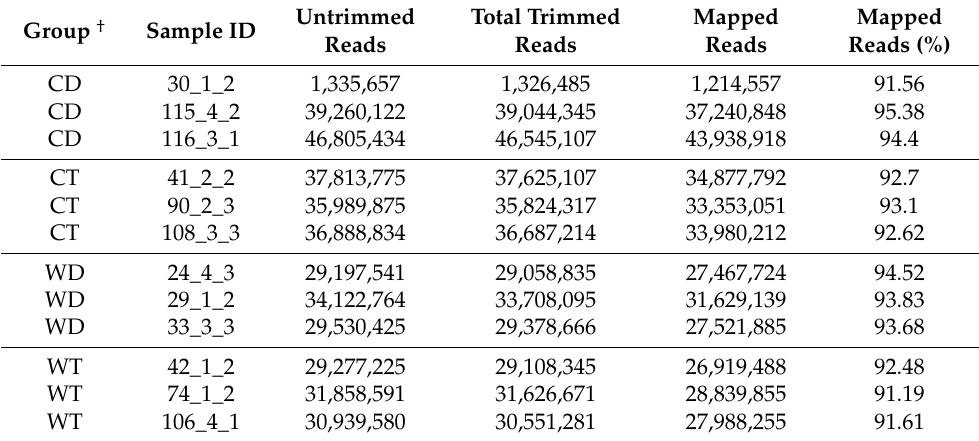
Table 2. Summary of sequencing and mapping data for the R. kuepferi transcriptomes, against the pseudoreference resulting from Trinity de novo assembly of all reads from diploid samples.